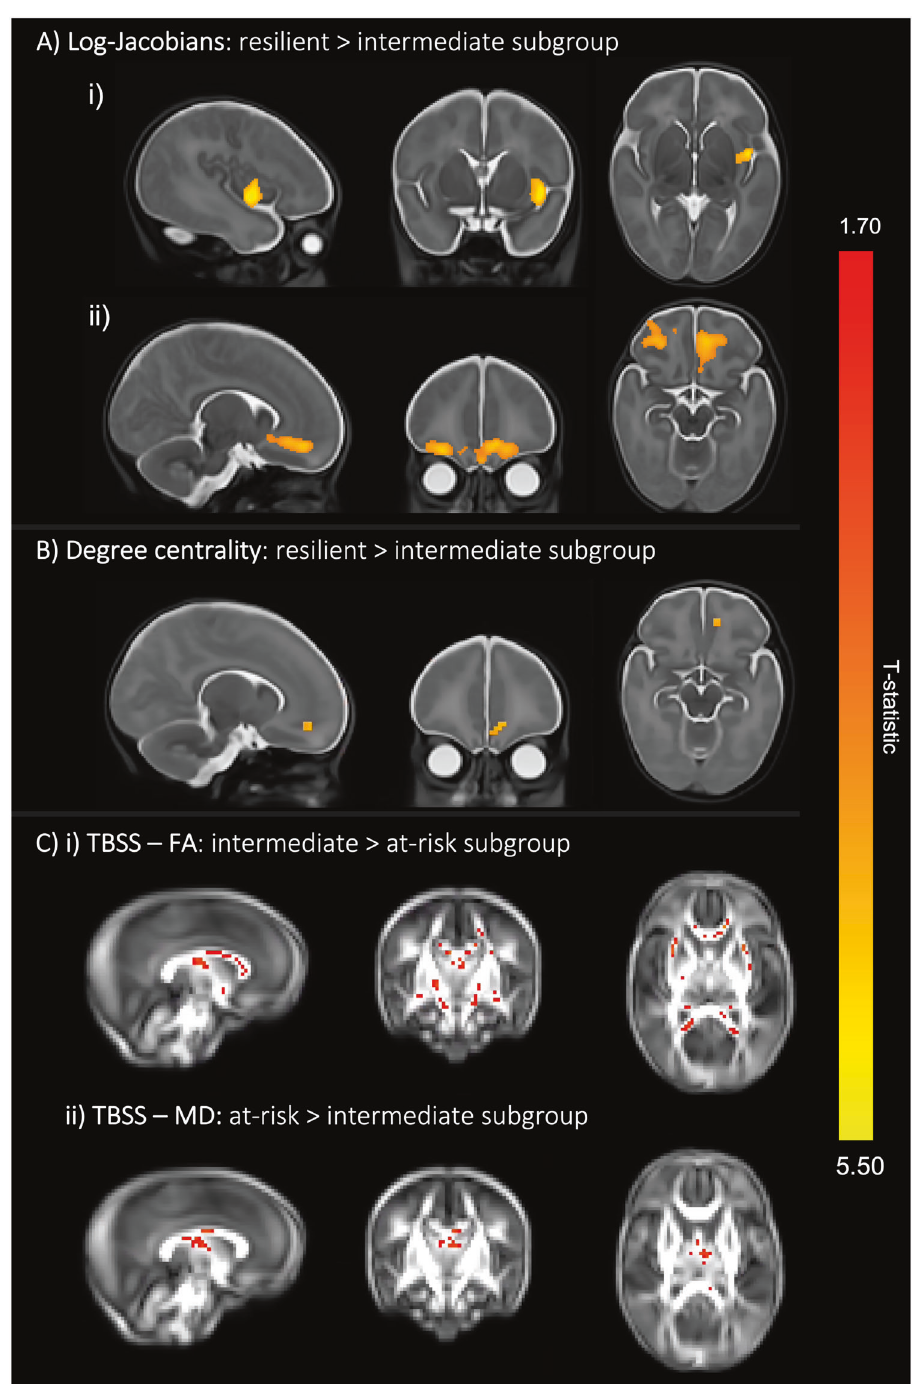
Fig. 4 Three-cluster solution brain differences at term-equivalent age. A Colored voxels indicate regions with signi fi cantly larger log- Jacobian determinant values in the resilient subgroup (subgroup 1) compared to the intermediate subgroup (subgroup 3) in i) left insula and the ii) bilateral orbitofrontal cortices ( p < 0.05). GLM included sex and PMA at scan as covariates and TFCE and FWE corrections were applied. B Voxels showing signi fi cantly larger degree centrality values in the resilient subgroup (subgroup) 1 compared to the intermediate subgroup (subgroup 3) are seen in an overlapping left orbitofrontal region at p < 0.05. GLM included sex, PMA at scan and motion (standardized DVARS) as covariates; TFCE and FWE were applied. C Colored voxels represent white matter regions showing i) signi fi cantly higher FA values in the intermediate subgroup compared to the at-risk subgroup and ii) signi fi cantly higher MD values in the at-risk subgroup compared to the intermediate subgroup ( p < 0.05). T-statistic values are represented in the color bar, where red colored voxels indicate smaller T-statistic values and yellow voxels indicate higher T-statistic values ranging between 1.70 and